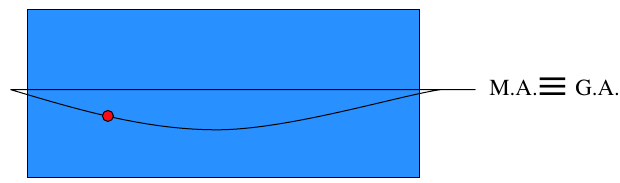
FIG. 1. (Color) Beam trajectory in a semiperiod of the magnet without any shaping of the pole. In this case the geometric (G.A.) and the magnetic (M.A.) axes coincide.